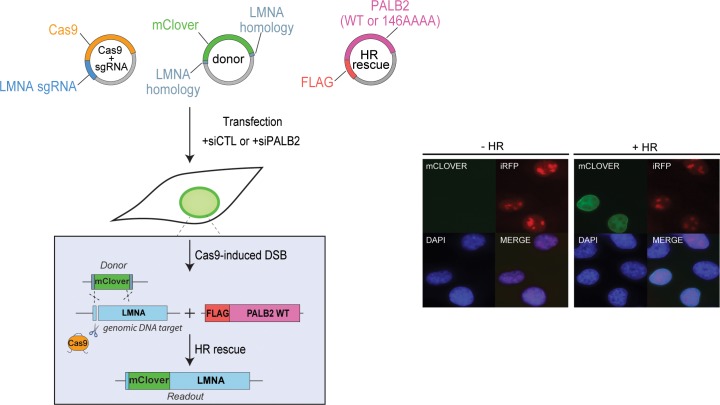
Representative images and schematic representation of CRISPR-Cas9/mClover-LMNA1 mediated HR assay.Following nucleofection, Cas9 creates a double-strand break in the LMNA locus leading to integration of the mClover gene at the LMNA locus by homologous recombination. Clover-labelled Lamin A/C proteins exhibit green fluorescence enriched at the nuclear periphery, which is indicative of successful gene targeting by homologous recombination.